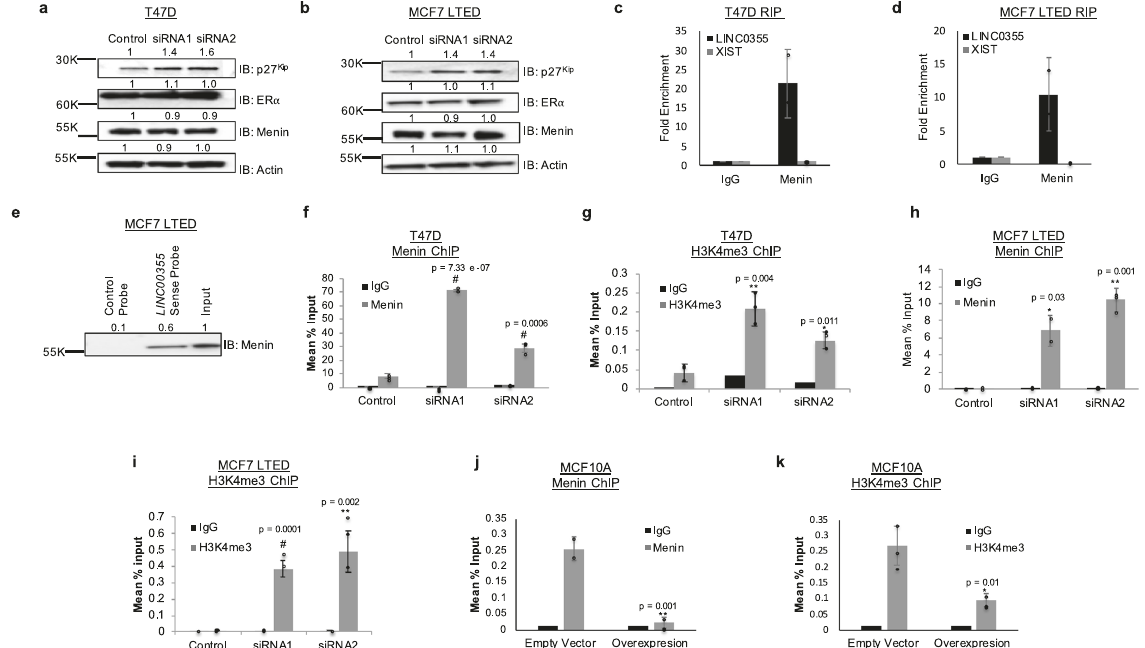
Fig. 5 LINC00355 binds to MENIN to regulate p27 KIP expression . Protein expression in a T47D and b MCF7 LTED cells upon LINC00355 knockdown. Estrogen Receptor α (ER α ). Fold change normalized to control. LINC00355 RNA immunoprecipitation (RIP) of MENIN in c T47D and d MCF7 LTED cells. e MCF7 LTED RNA pull-down of LINC00355 with MENIN. T47D cell line chromatin immunoprecipitation (ChIP) of f MENIN and g H3K4me3 at the CDKN1B promoter with knock down of LINC00355 . MCF7 LTED cell line ChIP of h MENIN and i H3K4me3 at the CDKN1B promoter with knock down of LINC00355 . MCF10A overexpression cell line ChIP of j MENIN and k H3K4me3 at the CDKN1B promoter. * p value < 0.05, ** p value < 0.005, # p value < 0.0005. All data are presented as mean values ± s.d, analyzed by two-tailed paired t test, and repeated more than two times. Source data are provided as a Source Data